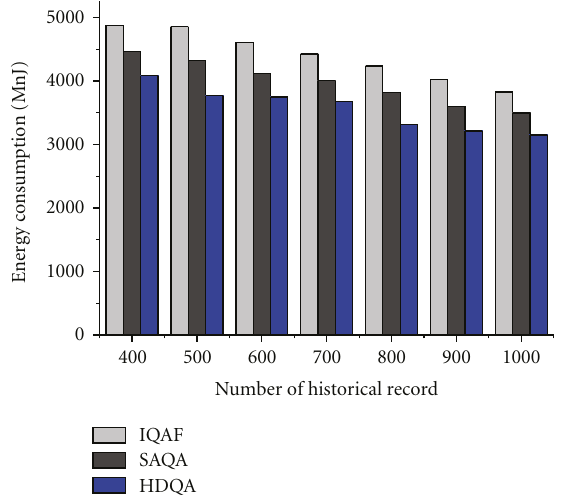
Figure 14: Energy sensitivity of total query.